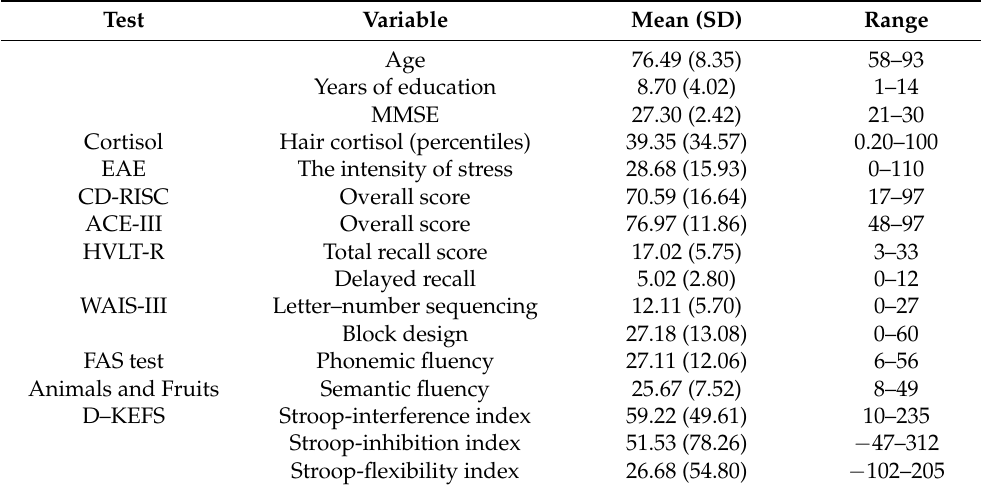
Table 1. Descriptive statistics of socio-demographic, cognition, and stress